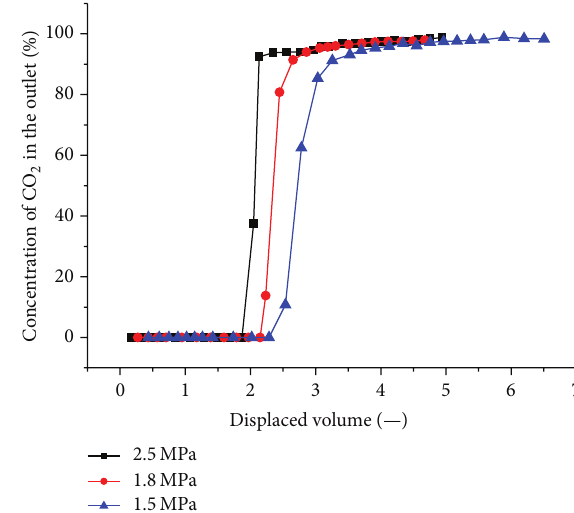
Figure 12: Influence on the N 2 concentration by gas injection pressure.